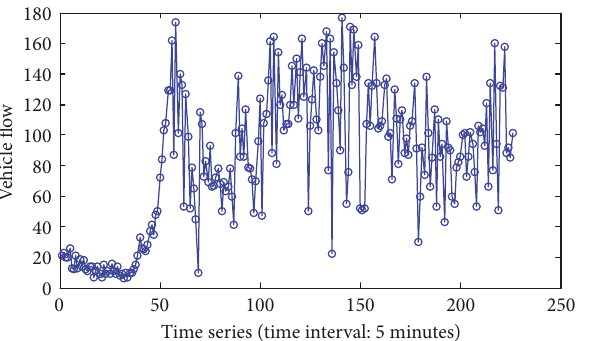
Figure 4: Historical traffic flow data.